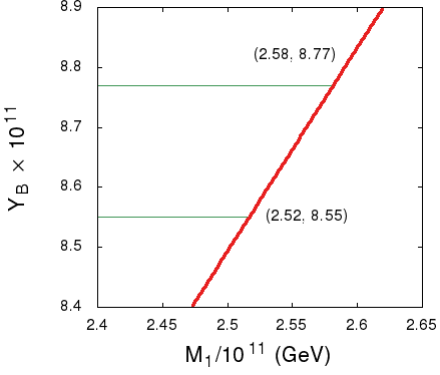
Figure 10 . A plot of the (cid:12)nal Y B for di(cid:11)erent values of M 1 for the normal light neutrino mass